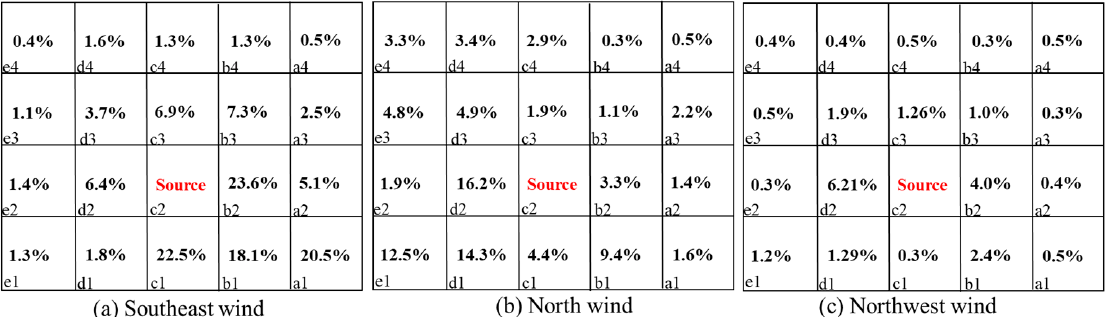
Figure 13. Re-entry ratio ( R K ) of each room under three wind directions with the pollutant source located in room c2 in Q1.